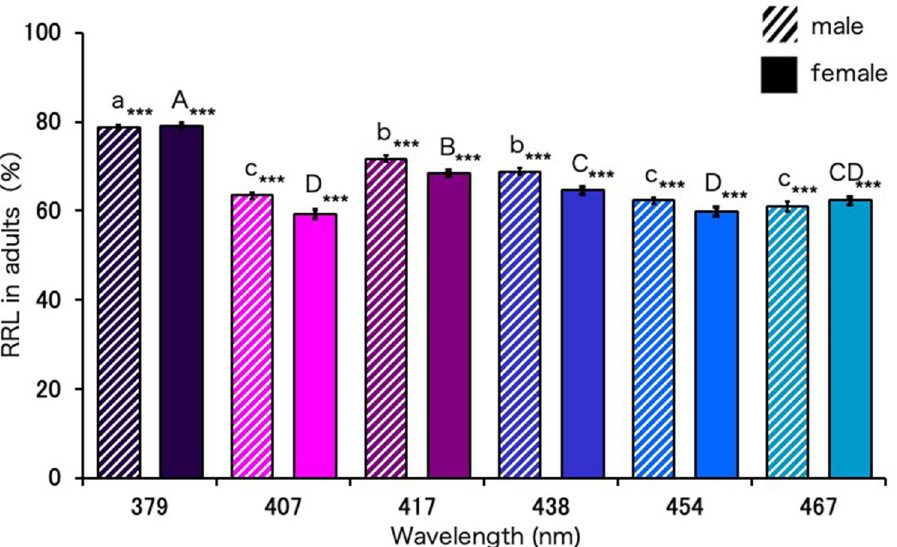
Figure 4. Reduction rate of longevity (RRL) of Aedes albopictus adults irradiated with blue light. Data represent the means ± standard errors. Asterisks above the bars indicate significant differences between the treatments (UVA and blue light irradiation) and control [dark condition (DD)] (Steel test, *** p < 0.001). Bars with the same letters are not significantly different (Steel–Dwass test, p > 0.05). Fifty replications (5 adults × 10 Petri dishes) were